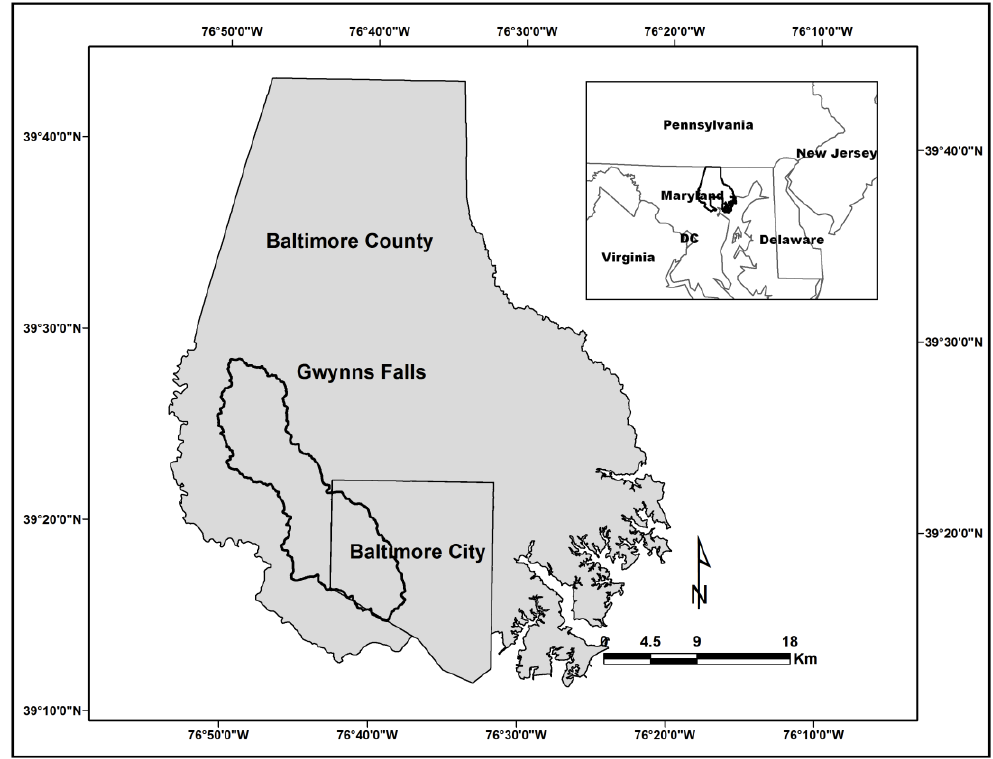
Figure 1. The Gwynns Falls watershed includes portions of Baltimore City and Baltimore County, MD, USA, and drains into the Chesapeake